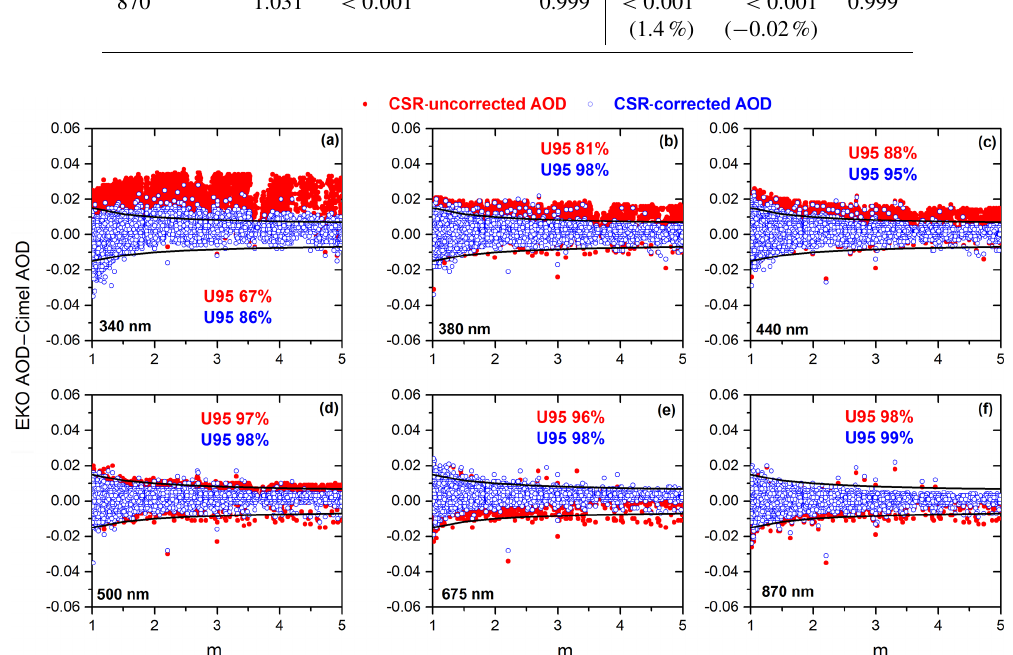
Figure 11. AOD differences (EKO AOD–Cimel AOD) versus the optical air mass ( m a ). Black lines represent the U 95 uncertainty limits.